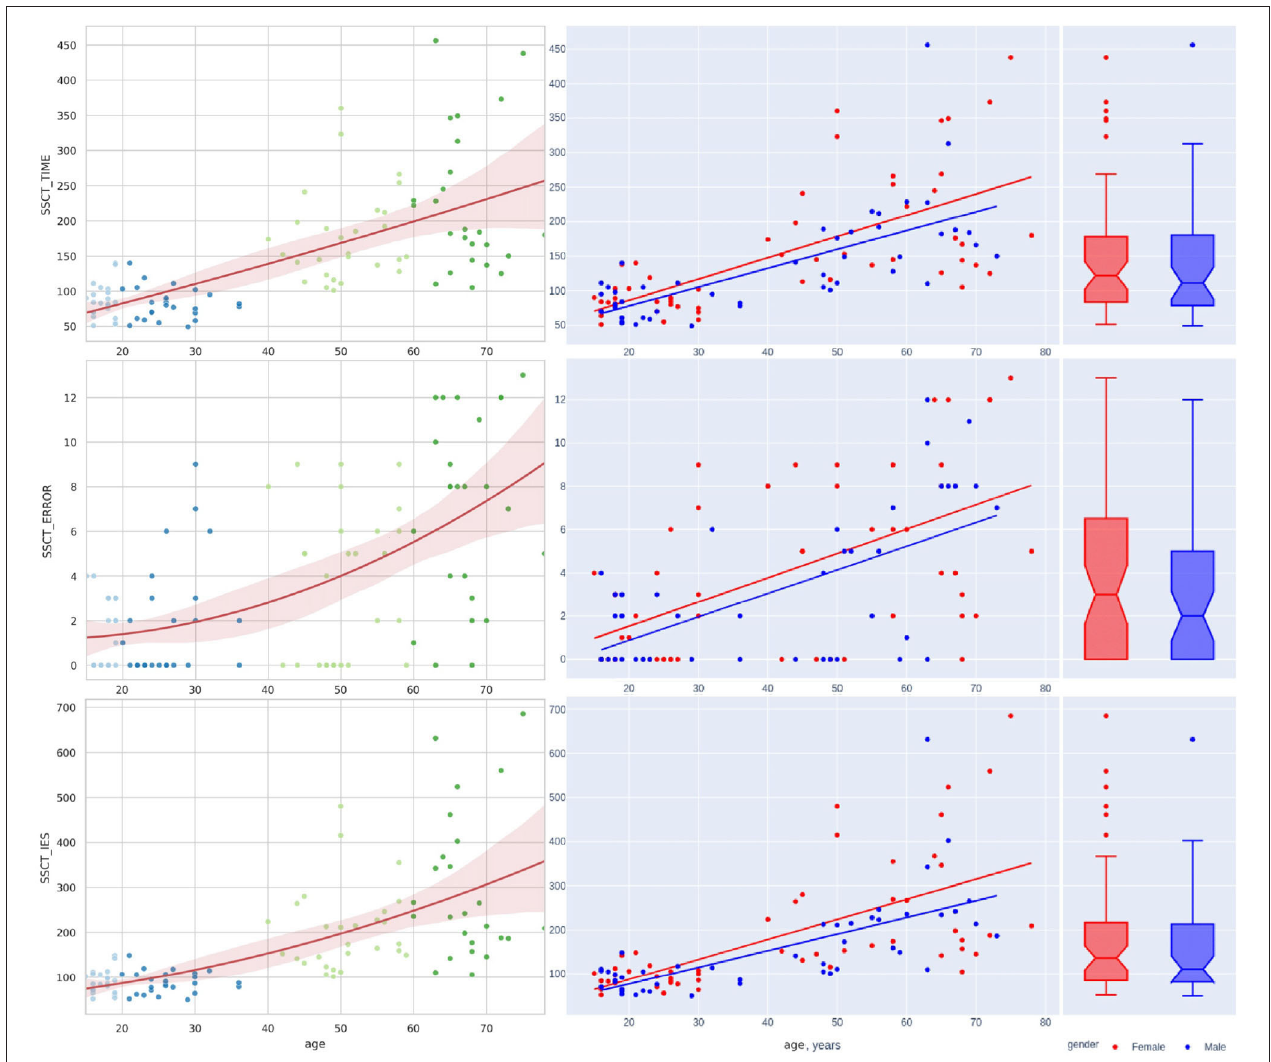
FIGURE 4 | Distribution of reaction time and accuracy attributes in Stroop switching card test by